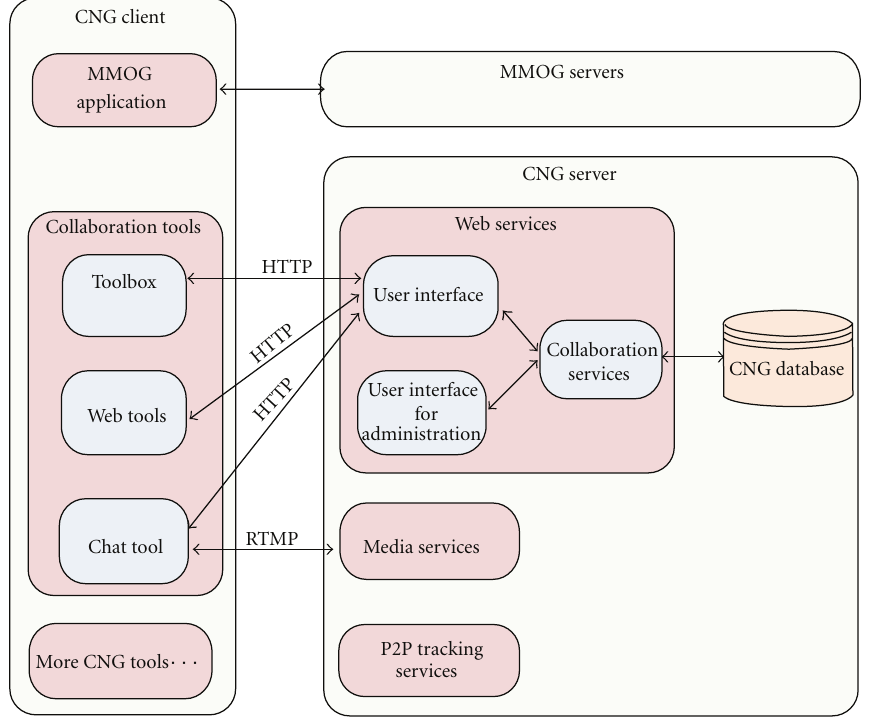
Figure 2: System architecture for the provision of community and collaboration services.